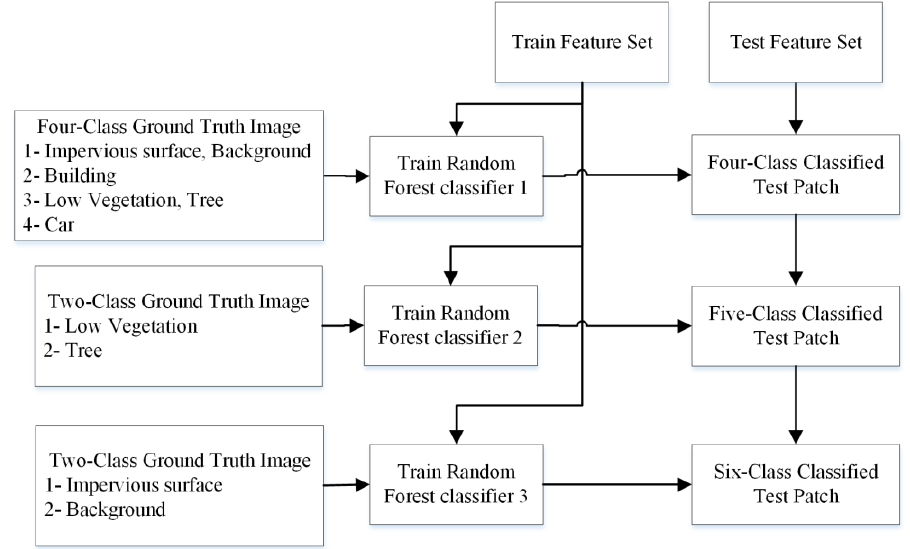
Figure 7. Multi-level Random Forest